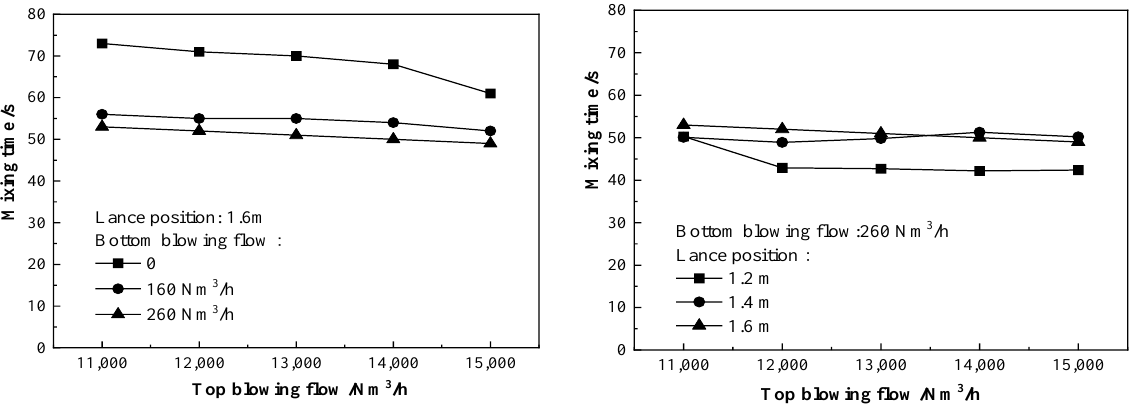
Figure 5. Effects of bottom blowing gas flow, top blowing gas flow and oxygen lance position on the mixing time of molten bath.